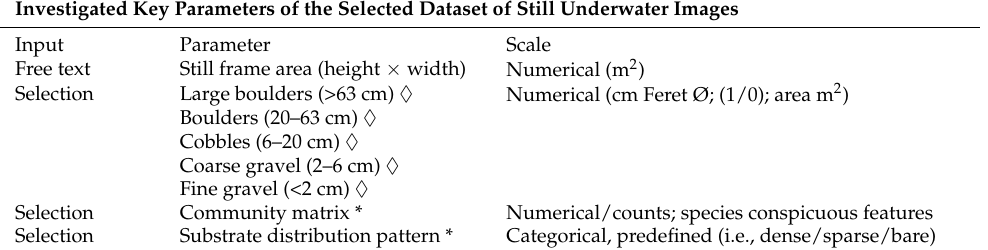
Figure 3. Schematic overview of the key UI acquisition and processing steps. ( a ) Video frame gear. ( b ) Video segmentation, selection of still frames; and ( c ) georeferencing (displayed in a geographical information system (GIS) as point locations along a transect). ( d ) Extraction of numerical parameters from still frames; a detail (to scale) is shown wherein stones ROIs are digitised and labelled as colonised/uncolonised, allowing the derivation of Ø and the surface area of each individual ROI for each still frame. Table 2. Investigated parameters form the dataset of calibrated underwater still frames obtained from underwater videos. Interpretation; ♦ = colonised/uncolonised. * = not explicitly used in this investigation. Count and areal measurements were standardised to an identical sample size of 1 m 2 .